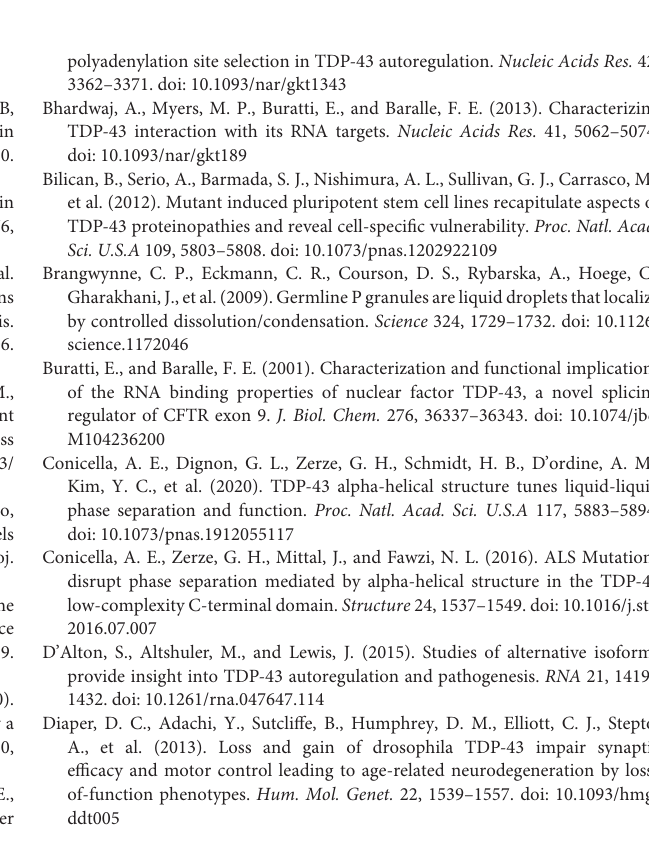
are summarized in Table 1 . (H) ANOVA analysis of the IC 50 values comparing WT and mutant TDP-43. *** P ≤ 0.001; ns, no significance. Supplementary Figure 4 | The ALS-associated M337V mutation decreases solubility and affects the solubility of co-expressed endogenous TDP-43. (A) TDP-43 solubility measured in HEK293 cells stably expressing a single copy of WT or M337V upon tetracycline induction. (B) Lysates of cells induced for 72 h were fractionated into RIPA and Urea-soluble fractions. The levels of transgene and endogenous TDP-43 were measured by immunoblotting (representative blots shown). Blots were probed with TDP-43 and GAPDH as loading control. High exposure of the immunoblot is included to compare levels in the Urea fraction. (C) The proportion of soluble WT and M337V transgenes is plotted in addition to that of endogenous TDP-43 from WT and M337V-expressing cell lines. Mean and SD of ≥ 3 biological replicates. (D) Representative immunofluorescence of HA-TDP-43 WT and M337V-expressing cells showing the predominantly nuclear detection of endogenous and HA-tagged TDP-43, n = 3 biological replicates. Scale bars, 10 µ m. Supplementary Figure 5 | M337V expression decreases the clearance of RNA binding proteins linked to ALS. (A,B) Representative immunoblots of HEK293 cells stably expressing HA-tagged WT or M337V TDP-43 for 72 h upon tetracycline induction. Cells were then treated with cycloheximide (CHX, 100 µ g/mL) and samples were taken at different time points post-CHX treatment, as indicated. Membranes were probed with TDP-43, Matrin-3, and FUS antibodies. GAPDH was used as a loading control. Supplementary Table 1 | List and sequence of DNA oligonucleotides used for cloning and mutagenesis. Supplementary Movies 1–3 | Specific RNA promotes liquid properties of TDP-43 condensates. TDP-43 (4 µ M) in no-RNA conditions (1) or mixed